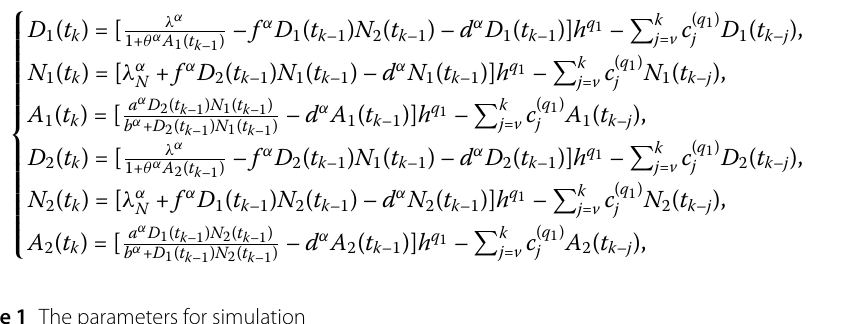
Table 1 The parameters for simulation